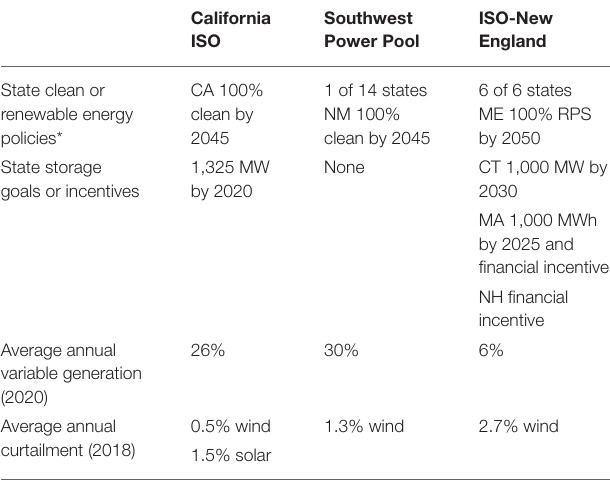
TABLE 2 | State energy policies, variable renewable generation, and curtailment across selected regional transmission organizations.